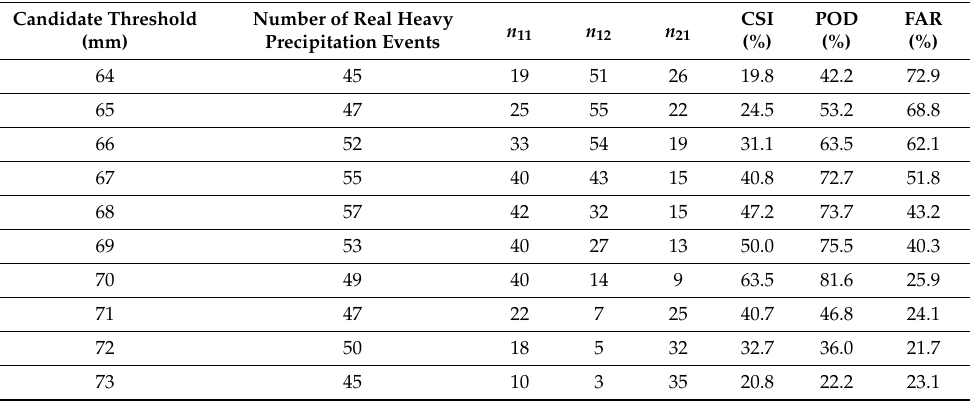
Table 4. Determination of the optimal threshold for the predictor of PWV value in June at the HKSC-KP station from a set of candidate values in June from 2010 to